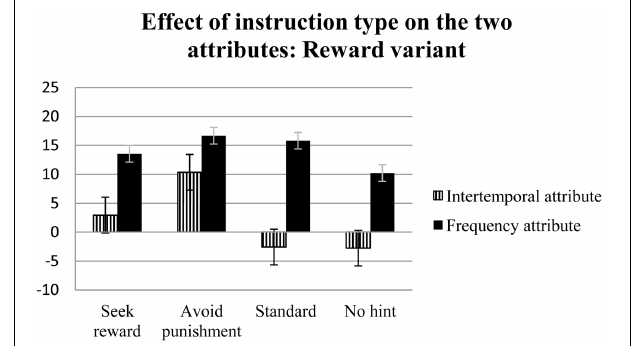
Values shown are means and standard deviations (in parentheses).